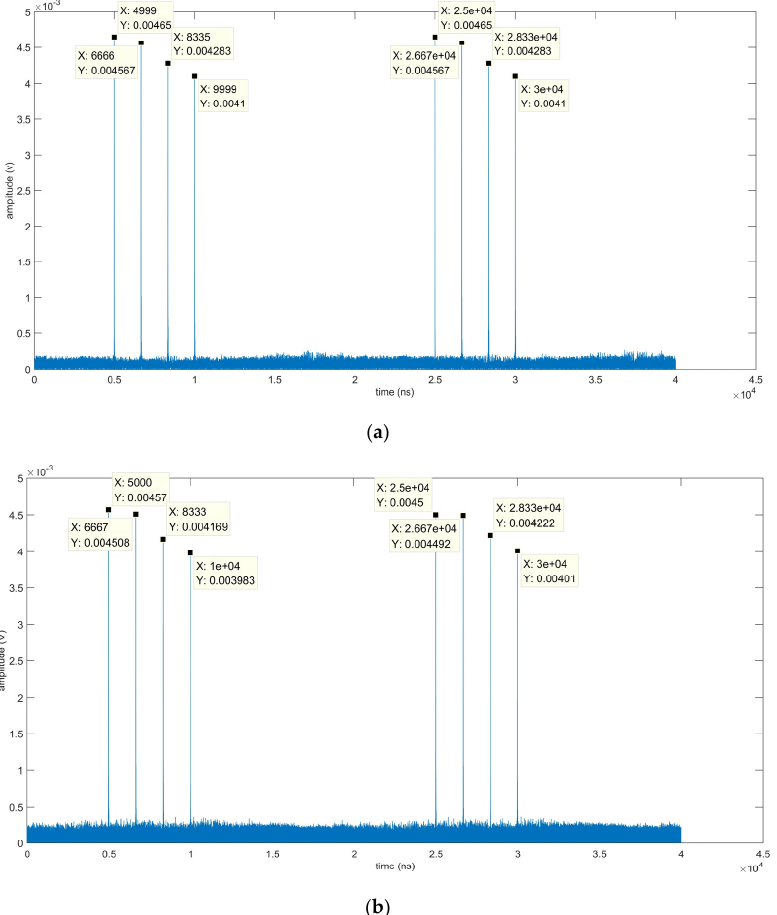
Figure 9. Experiment results with four input frequencies calculated by the classical time-domain pulse compression method ( a ) and the LPSA algorithm ( b ) at 8 G sampling rate.